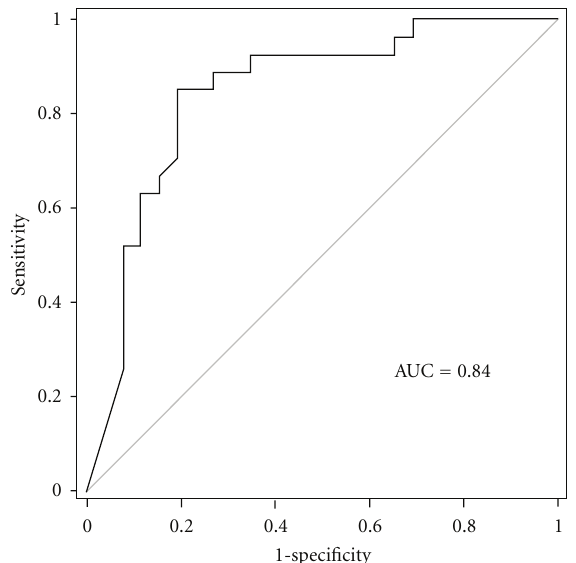
Figure 2: ROC curve showing the significant prognostic value of PCT for neurological